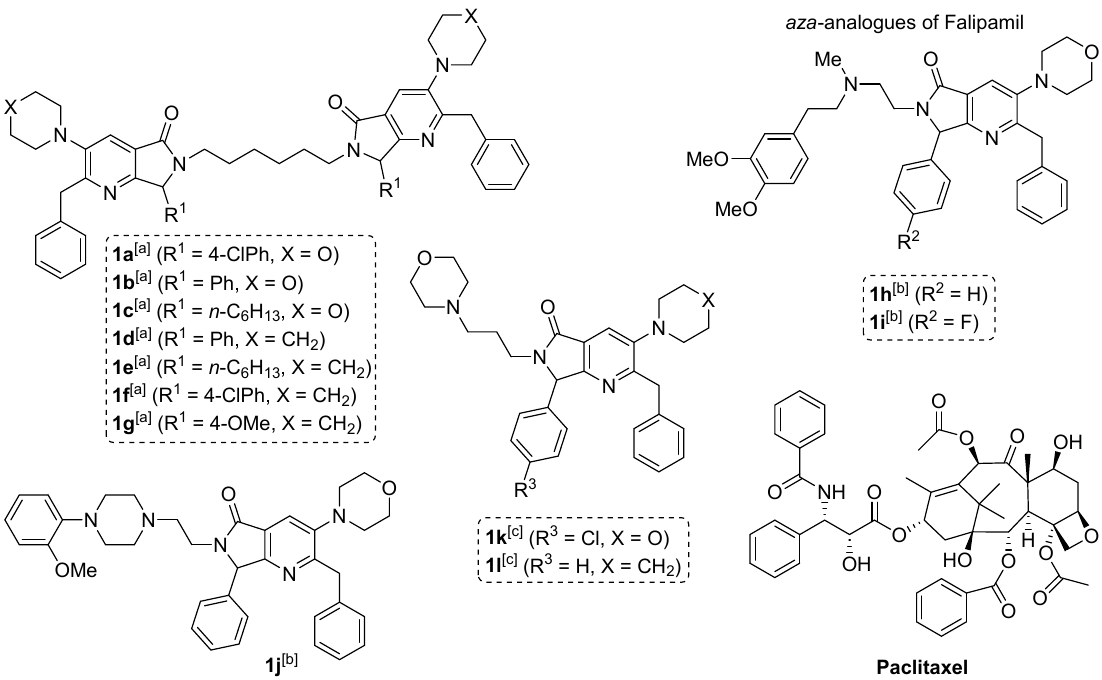
Figure 1. Initially tested pyrrolo[3,4- b ]pyridin-5-ones. [a] Synthesis reported in Reference [32]. [b] Synthesis reported in Reference [22]. [c] New pyrrolo[3,4- b ]pyridin-5-ones. The products were synthesized and used for the in vitro studies as racemic mixtures.